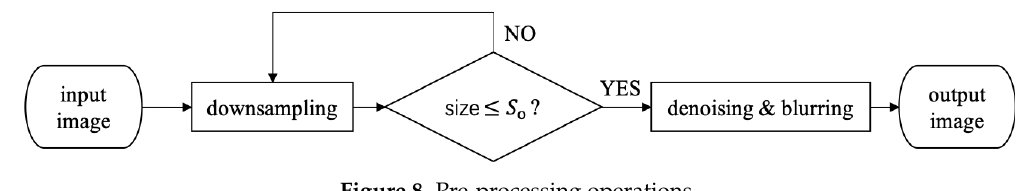
Figure 8. Pre-processing operations.